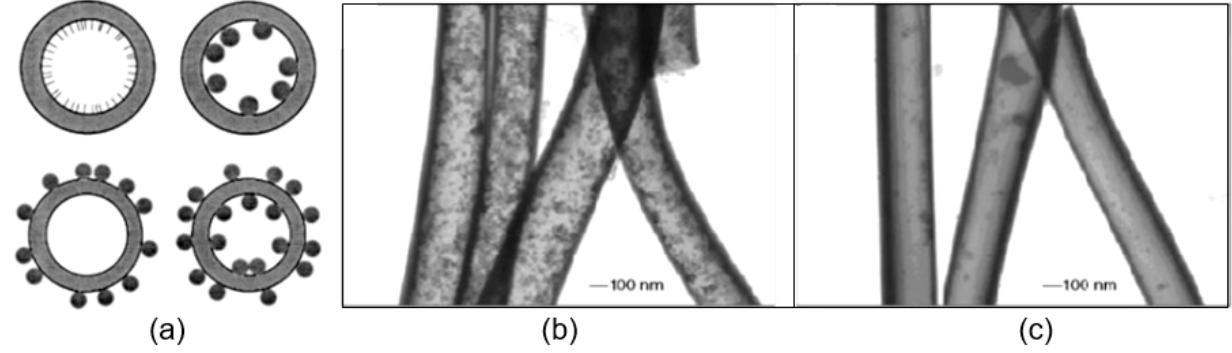
Figure 10. ( a ) Schematic drawings showing cross-sections of hollow nanofibers whose surfaces are derivatized with functional molecules (the top plate) and nanoparticles (NPs) (the other plates). ( b , c ) TEM images of hollow titania nanofibers immersed in an oil-based ferrofluid overnight. The hollow fibers are prepared by co-electrospinning, either with ( b ) or without ( c ) octadecyltrichlorosilane (OTS) added to the mineral oil. The interior of a hollow fiber is decorated by oil dispersible Au nanoparticles. Reprinted with permission from [149]. Copyright 2005 Wiley.